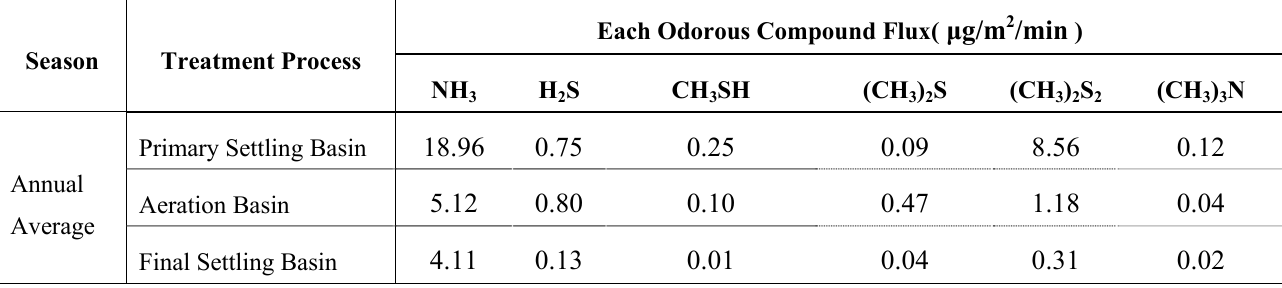
Table 6. Odorous Compounds Emission Flux ( μ g/m 2 /min) from the Wastewater Treatment